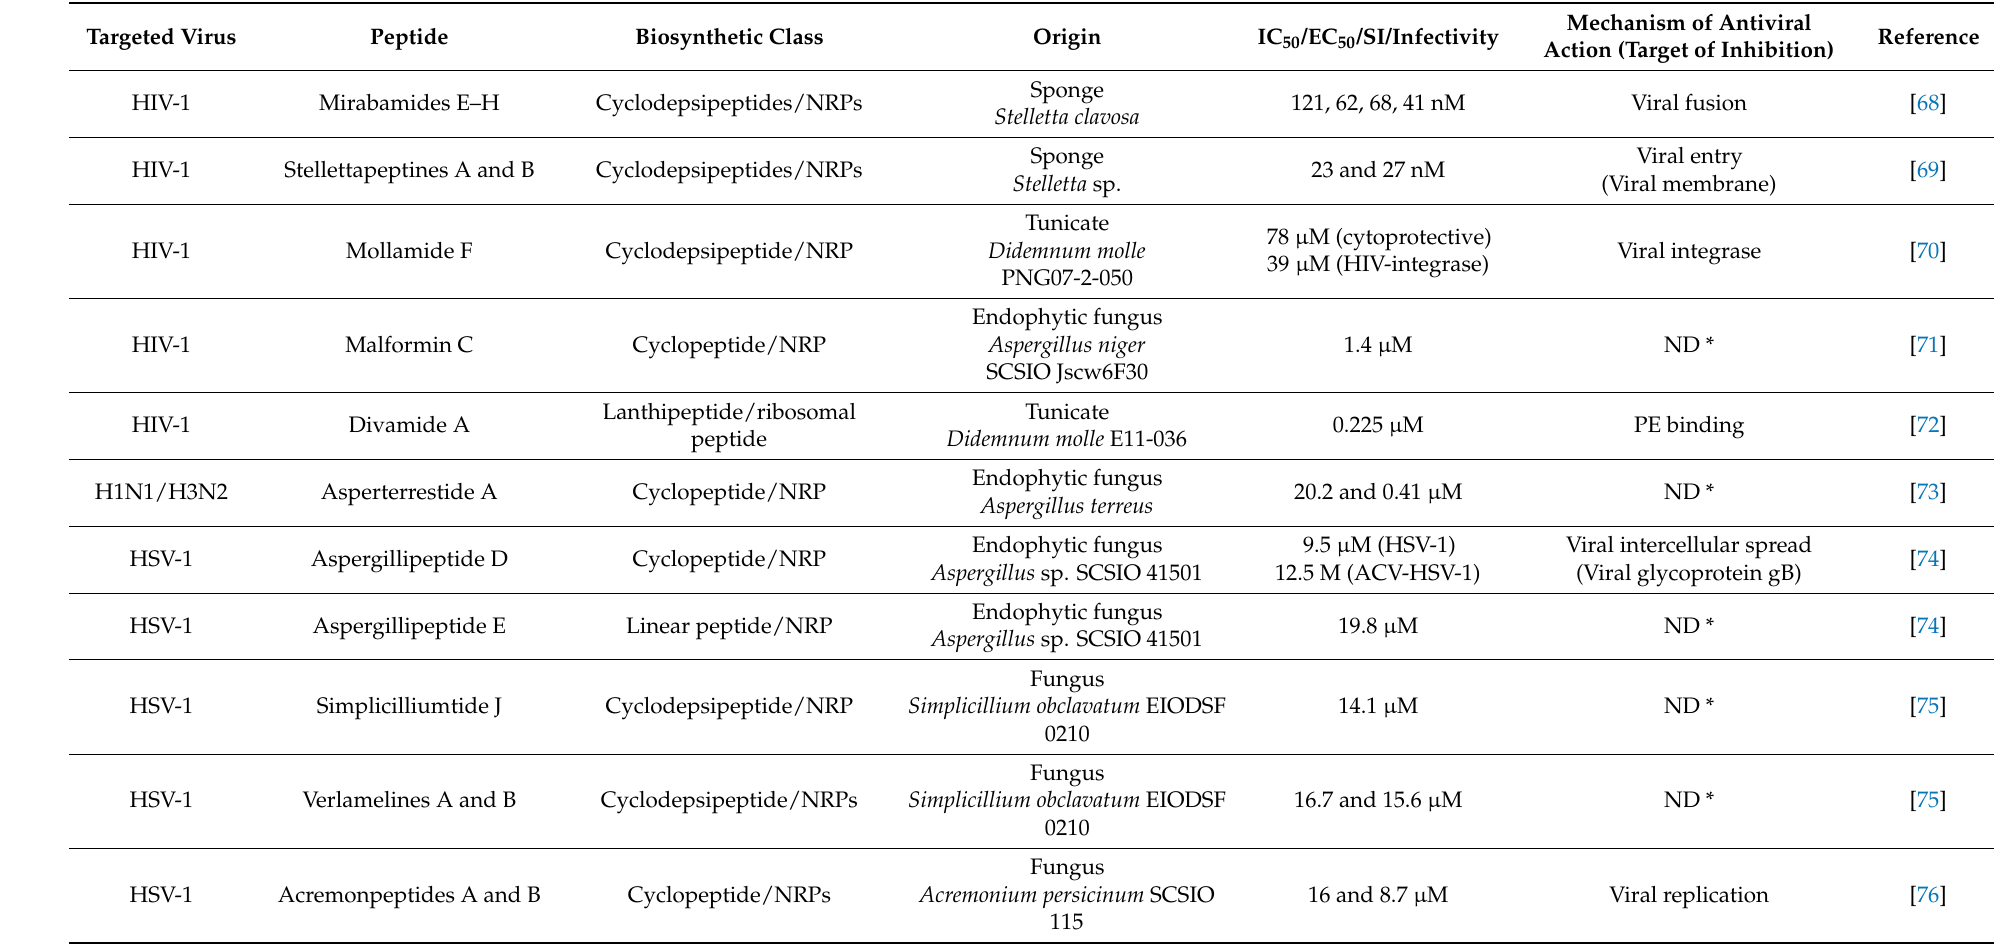
Table 1. Recent reported antiviral bioactive peptides derived from marine organisms during